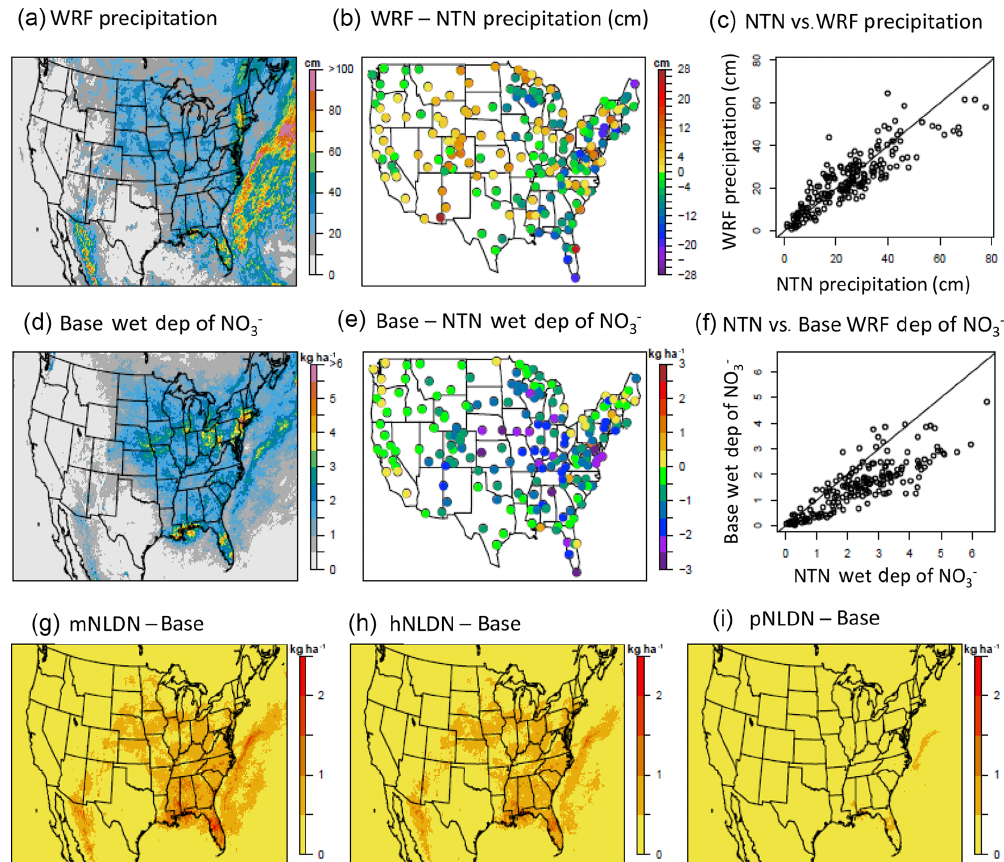
Figure 12. (a) – (c) shows precipitation estimates from WRF (a) , the bias in the WRF predicted precipitation at NTN locations (b) , and the corresponding scatter plots (c) . (d) – (f) shows wet deposition (dep) of nitrate estimates from the Base simulation (d) , the bias in the Base model estimates of wet deposition of NO − at NADP NTN locations (e) , and the corresponding scatter plots (f) . (g) – (i) shows the difference 3 in the LNO x sensitivity simulations and the Base case estimates of wet deposition of NO − for mNLDN – Base (g) ; hNLDN – Base (h) , 3 and pNLDN – Base (i) . All maps are based on accumulated values (precipitation or wet deposition) during June–August 2011. Precipitation totals are in centimeters (cm) and wet deposition totals are in kilograms per hectare (kgha − 1